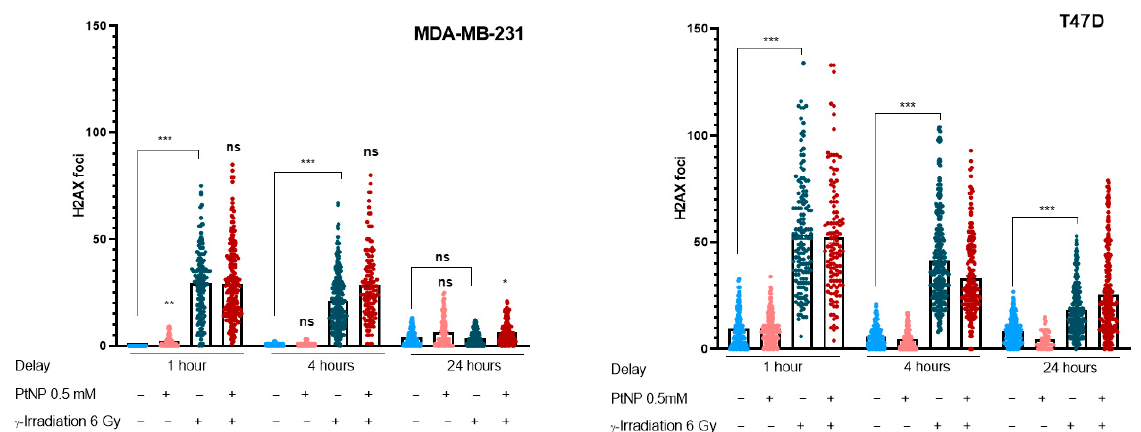
Figure 6. Double-strand DNA breaks counted after the 6 Gy irradiation of breast cancer cells pretreated with 0.5 mM PtNPs or not. The DSB foci were detected by labeling with H2A.X antibody and counted 1, 4, or 24 h after irradiation. For each condition tested, a minimum of 100 nuclei were investigated. An unpaired t-test was used to identify outliers, and a Kruskal–Wallis multiple comparison was conducted to determine the significance of the findings. Note: ns = non-significant; * p < 0.05, ** p < 0.01, and *** p < 0.001.